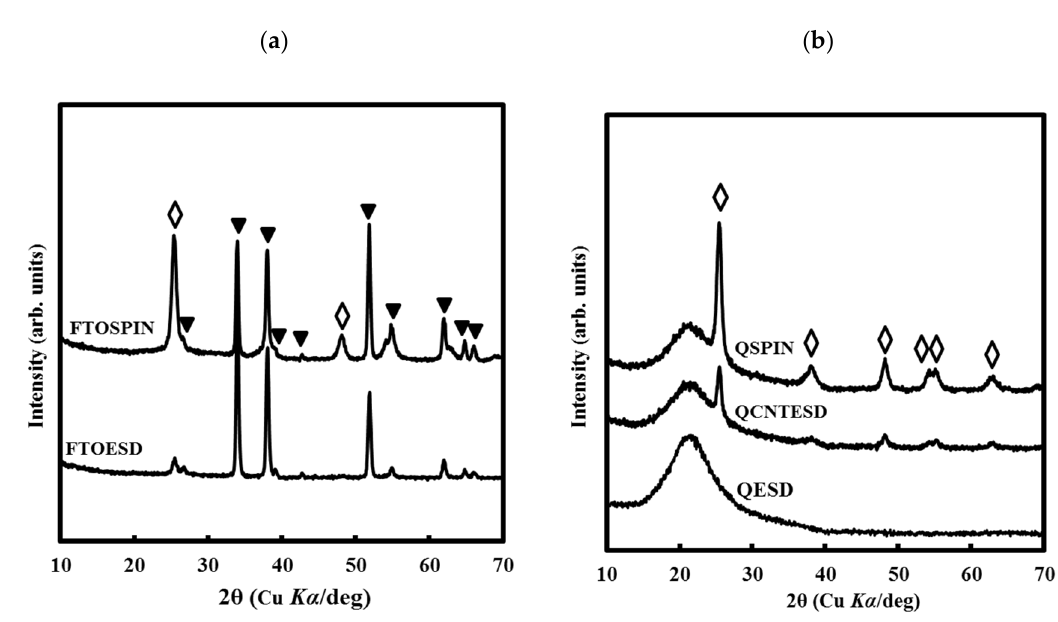
Figure 3. XRD patterns of the resultant thin films; ( a ) FTOESD and FTOSPIN; ( b ) QESD, QCNTESD, and QSPIN. The peak assignment is denoted as follows; ◊ anatase, ▼ SnO 2 in the FTO-precoated glass substrate.